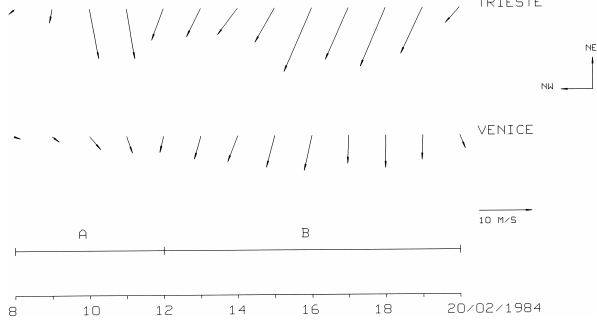
Fig. 11. Low-pass filtered series of the wind vector at the meteoro- logical stations Trieste (up) and Venice (down). A and B indicate episodes discussed in the